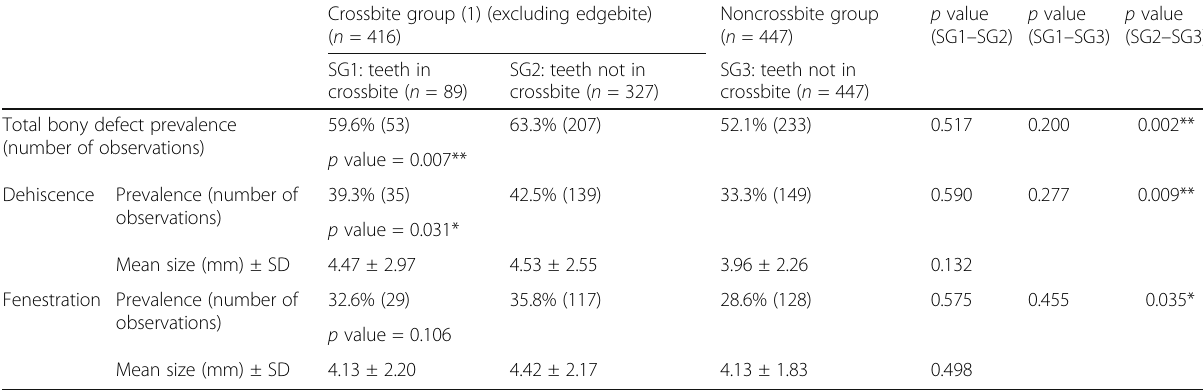
Table 10 Prevalence and mean size of total bony defects, dehiscence, and fenestration by subgroup. Teeth in edgebite are